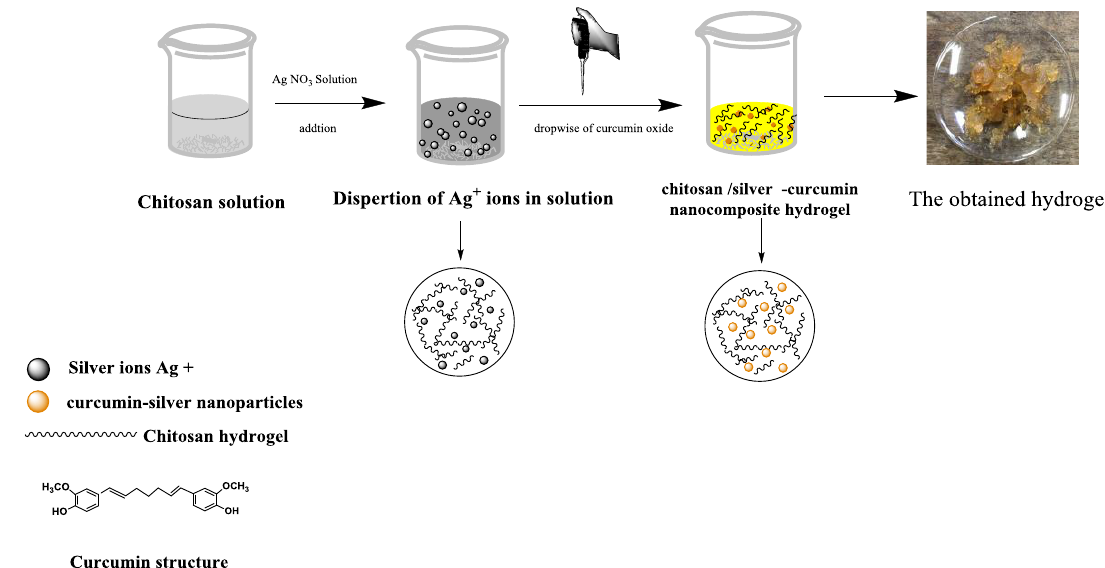
/ silver -curcumin nanocomposite